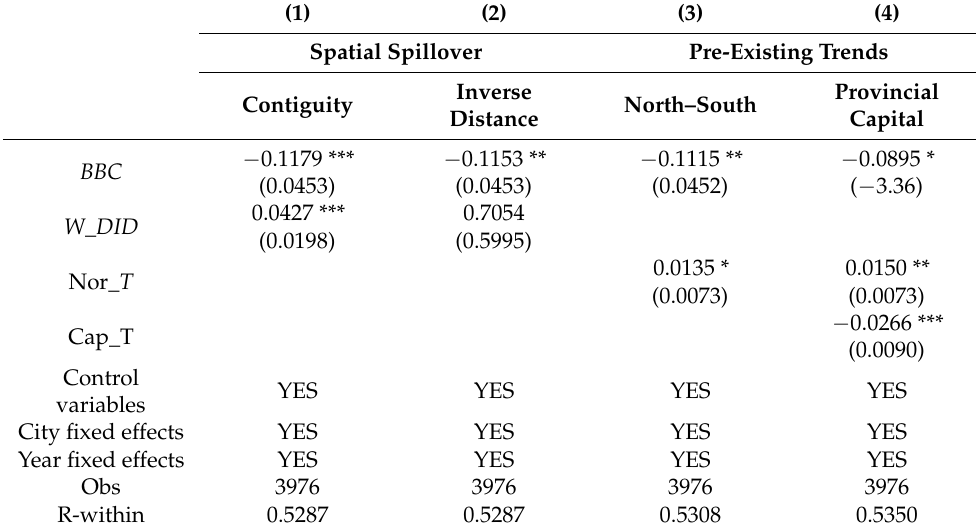
Table 3. Robustness test